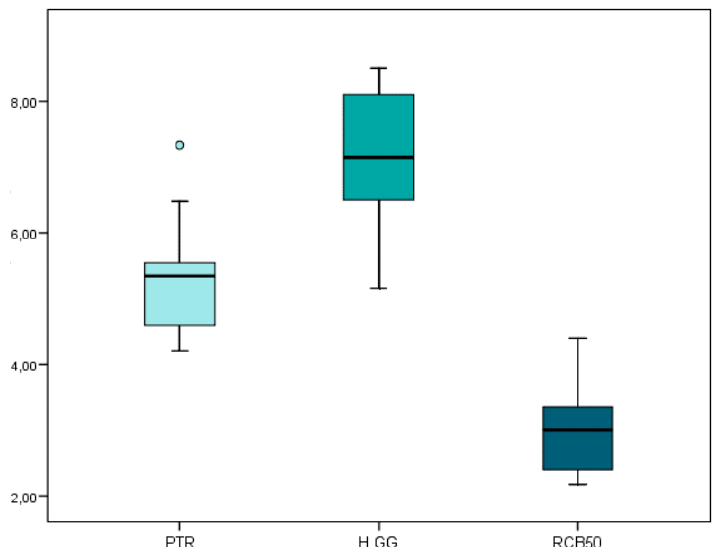
Figure 4. Box plot of the non-surgical endodontic retreatment working time (min) regarding the non-surgical endodontic retreatment techniques. PTR: ProTaper Retreatment endodontic rotary instruments; RCB50: Reciproc Blue endodontic reciprocating instrument; H-GG: combined root canal retreatment technique between Gates-Glidden drills and Hedstrom files.